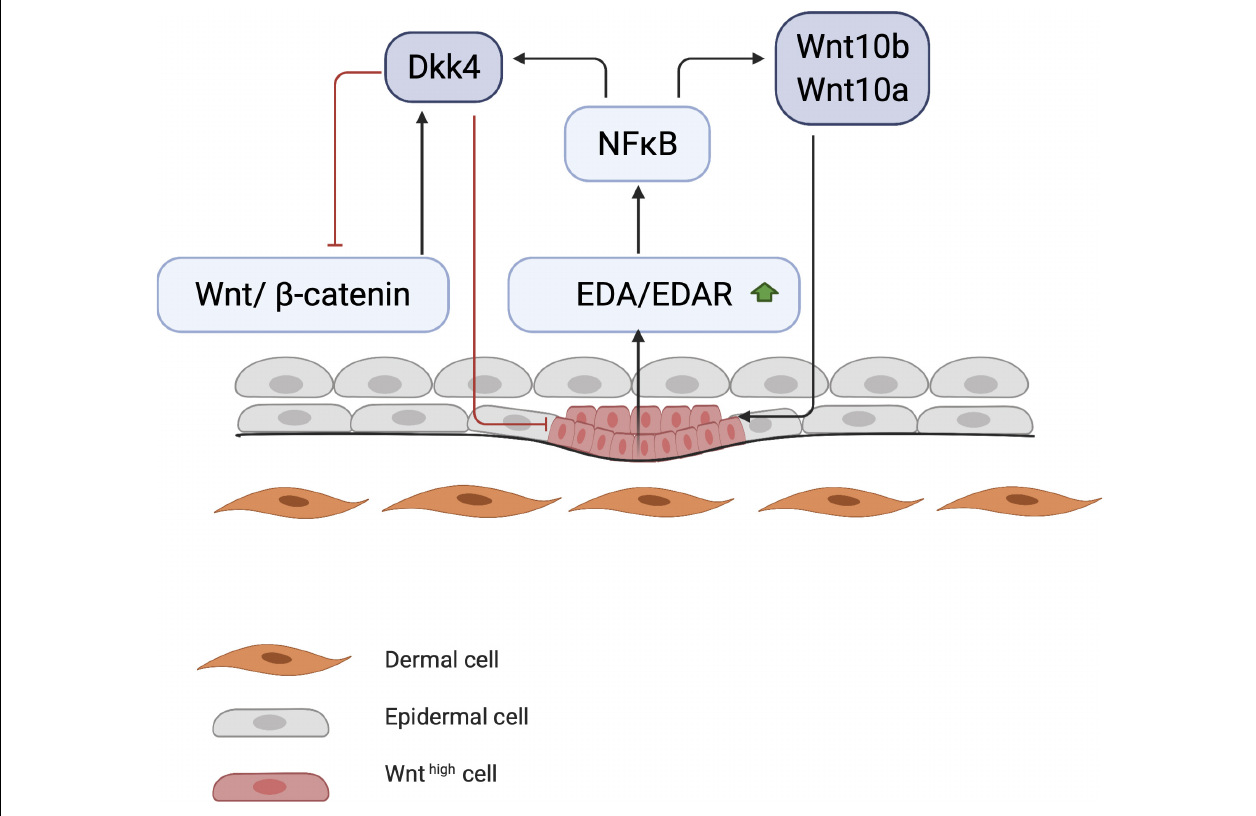
FIGURE 2 | Start of placode formation. During placode formation, NF- κ B produces inhibitory signals (DKK4) and stimulates WNT molecules (WNT10a and WNT10b). Stimulating and inhibitory signals create a WNT concentration gradient, where WNT high concentration results in placode